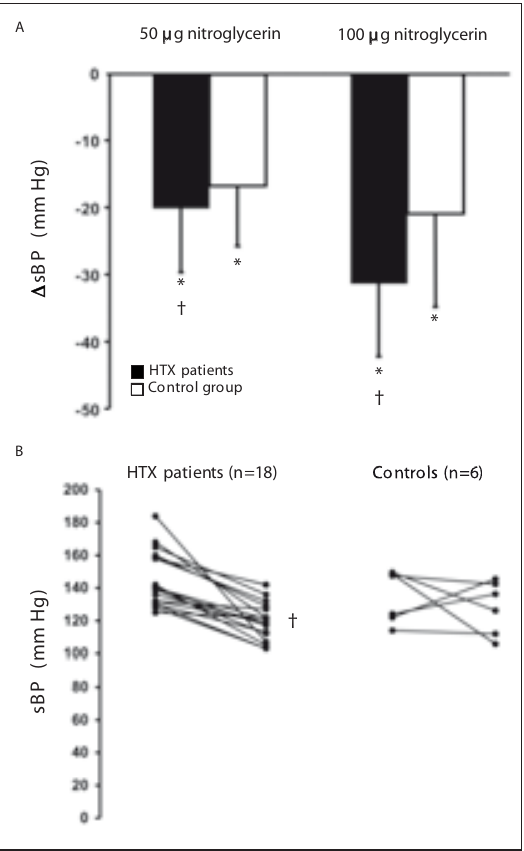
Figure 1 Delta systolic blood pressure ( D sBP) in HTx patients and in the HT group within a minute after administration of 50 m g and 100 m g nitroglycerin (A) and during the recovery time (8 ± 3 minutes after the last infusion of nitroglycerin) (B). We found a treatment effect after nitroglycerin infusion (p <0.001).This effect was true for both groups (p <0.01 for both groups), Interestingly, the HTx group showed a significantly more pronounced effect on sBP (p = 0.038 for group comparison). * p <0.05 or less vs baseline; † p <0.05 or less HTx vs controls. Data are expressed as mean ±